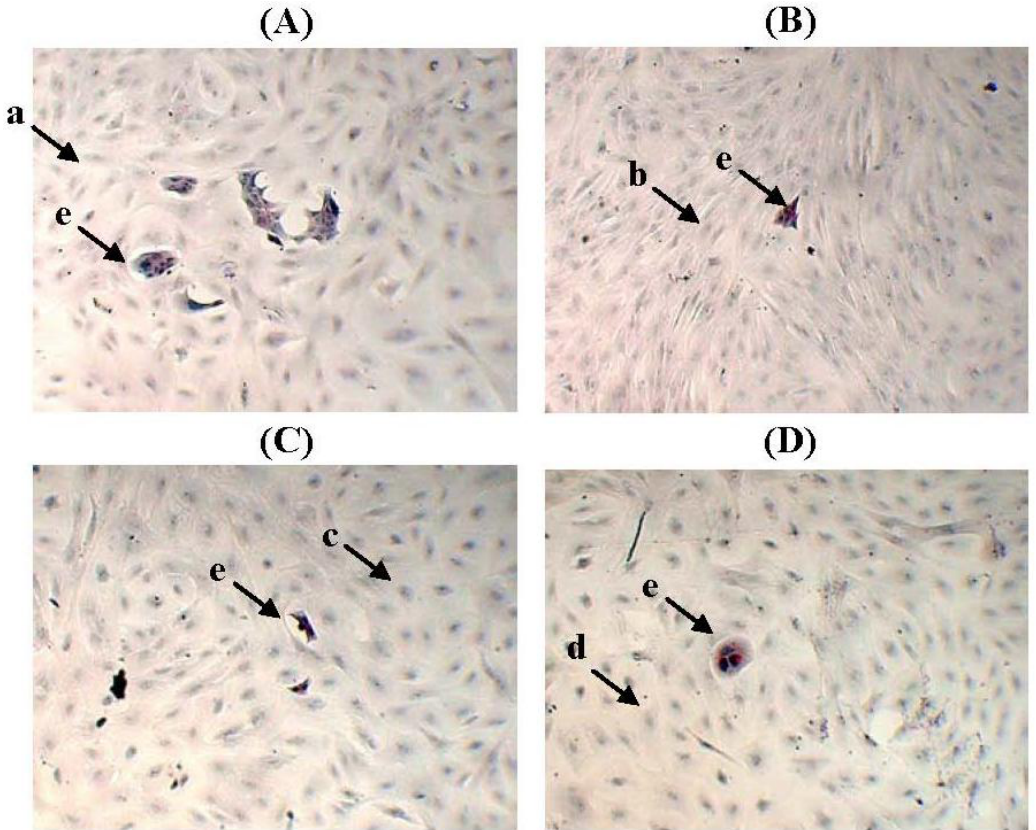
Figure 4. The morphologies of MCF-10A cells preincubated with ( A ) Culture Condition 1; ( B ) Culture Condition 2; ( C ) Culture Condition 3; and ( D ) Culture Condition 4. One hundred cells were used as the input for incubation, and the incubation was carried out for 1 week. The cells were stained with Oil Red O Staining. The pictures were taken with 200× magnification, where 0.01 mm was equal to 10 µm. Arrow a , b , c and d denote the MCF-10A cells preincubated with Culture Condition 1, 2, 3 and 4, respectively, whereas e denotes the BT-474 cells grown on the preincubated MCF-10A feeder